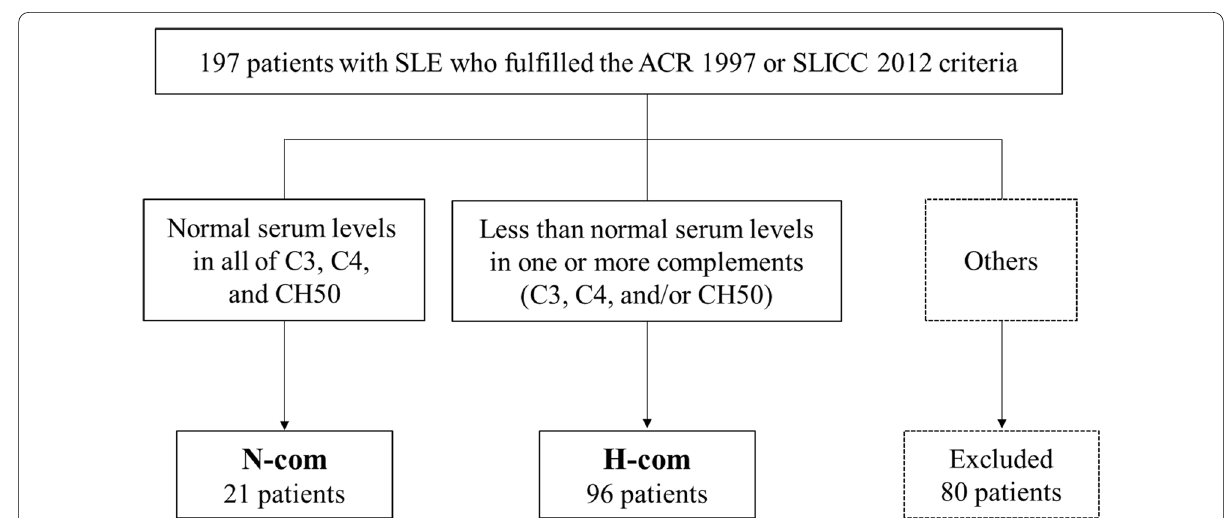
Fig. 1 Study design for enrolling patients. Of patients who fulfilled the American College of Rheumatology (ACR) 1997 or the Systemic Lupus International Collaborating Clinics (SLICC) 2012 criteria at the initial diagnosis, patients with normal serum levels of C3, C4, and CH50 (N-com) and those with lower than normal serum levels of one or more complements in C3, C4, and/or CH50 (H-com) were classified. Others: patients who were insufficient for determining N-com or H-com, those who had infection or malignancy, or those whose clinical information was insufficient for the analyses